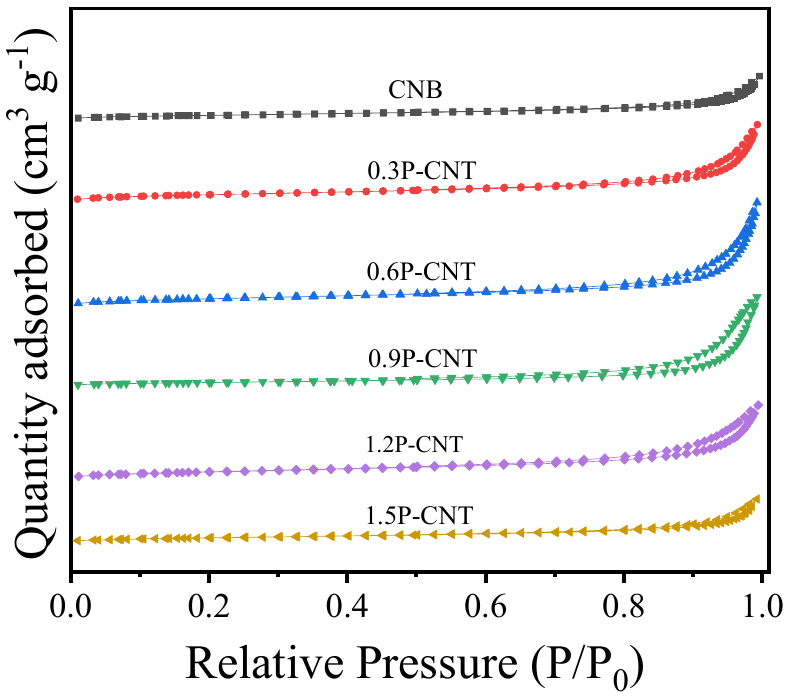
Figure 5. N 2 adsorption-desorption curves of the CNB, 0.3P-CNT, 0.6P-CNT, 0.9P-CNT, 1.2P-CNT, and 1.5P-CNT samples.